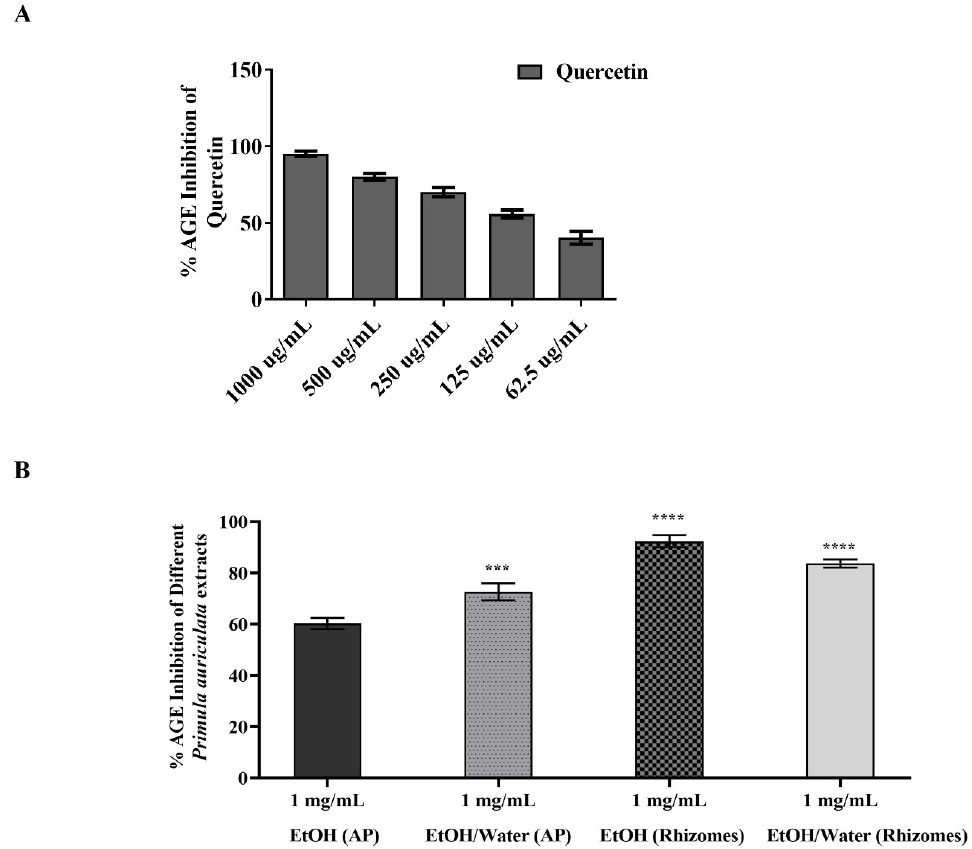
Figure 5. Effect of different concentrations of quercetin (in ( A )) and 1 mg/mL of EtOH and EtOH/wa- ter extracts obtained from aerial and root parts of Primula auriculata (in ( B )) on AGE formation. In ( B ), the EtOH extract obtained from aerial parts (AP) of Primula auriculata were compared to other extracts at the same concentration. In the statistical analysis, a p ≤ 0.001 value is shown with ***, and **** is indicated for p ≤